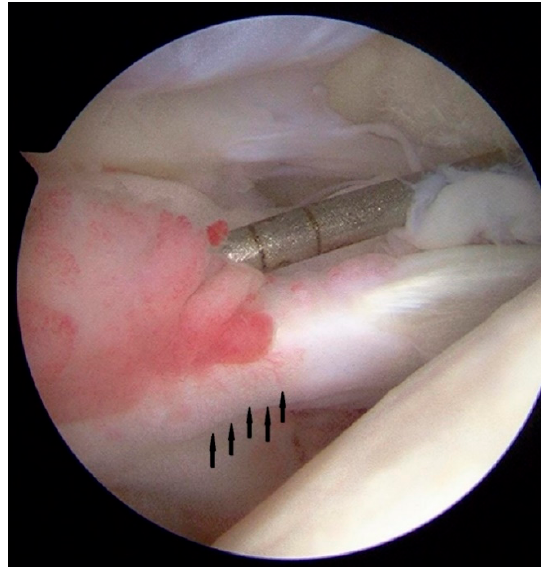
Figure 1. Arthroscopic view of the long head of the biceps brachii muscle tendon. The neovessels in the proximal part of tendon are seen (arrows) in the patient with symptomatic tendinopathy.